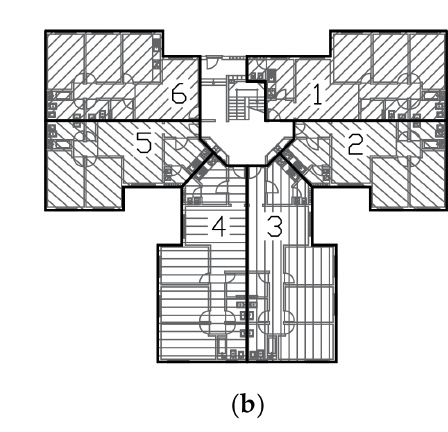
Figure 2. Geometry of the case study: ( a ) west facade; ( b ) typical